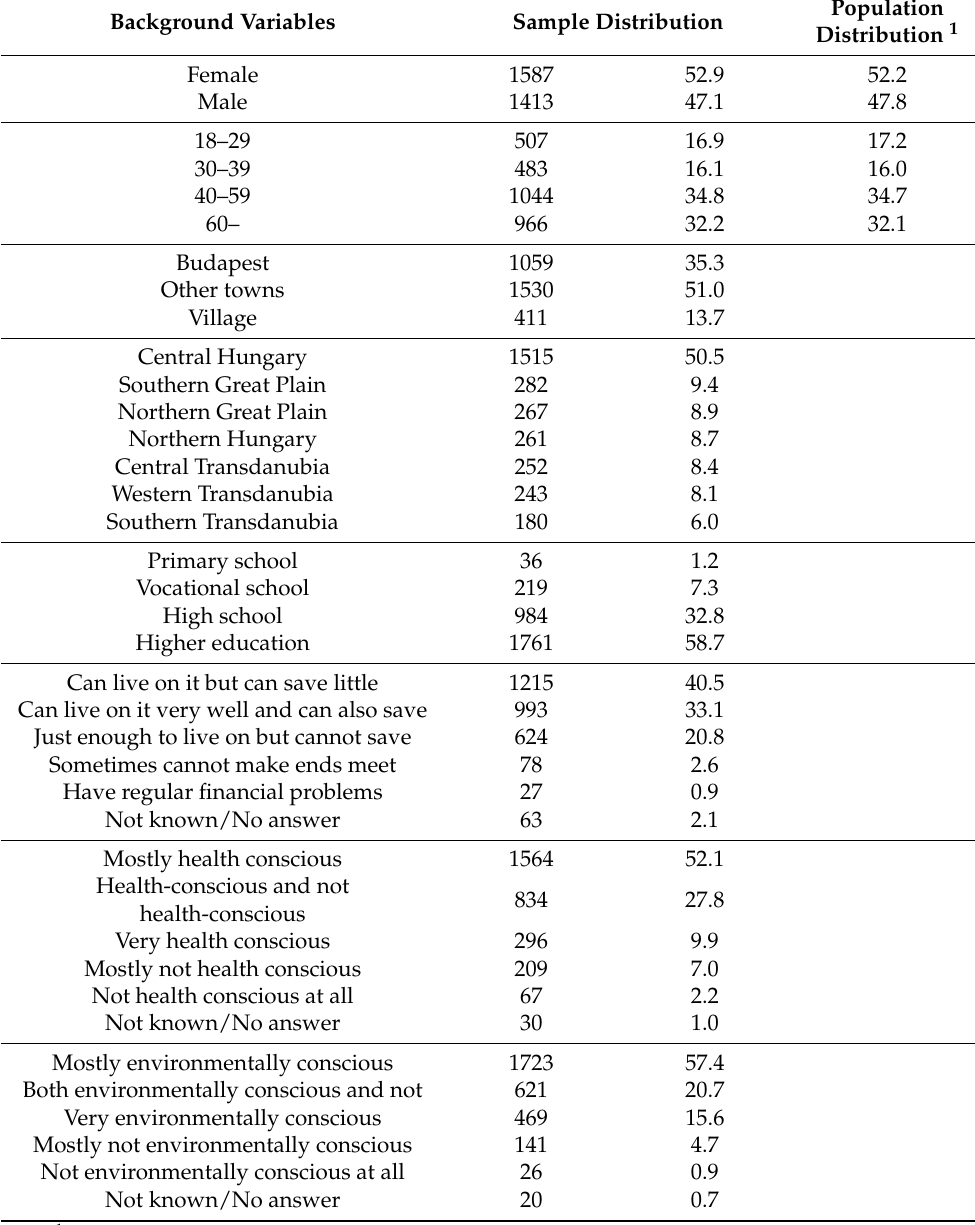
Table 2. Distribution of the sample according to the most important background variables (N = 3000) and population composition according to representative